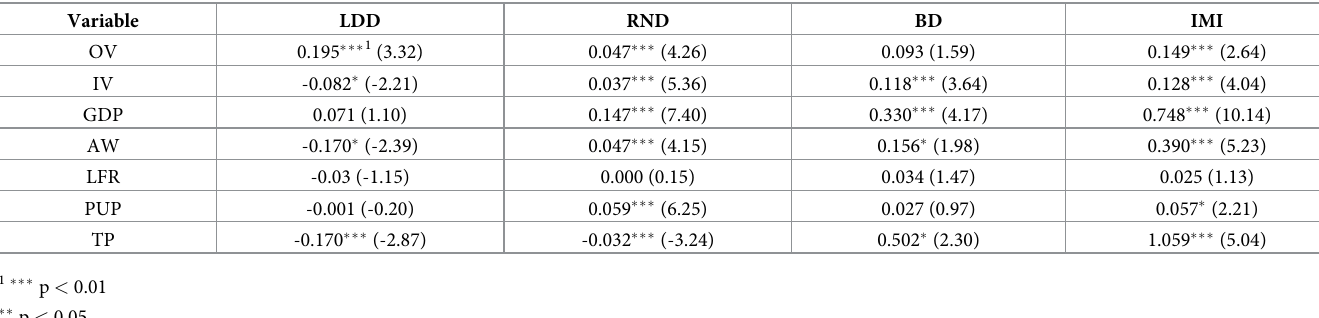
Table 6. Spillover effects of independent variables on health resources. Variable